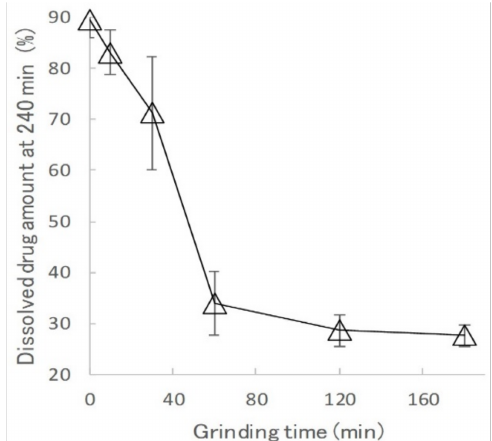
Figure 7. Effect of grinding time on the drug release amount (RA4) of the KGMH matrix tablets after 240 min dissolution test.